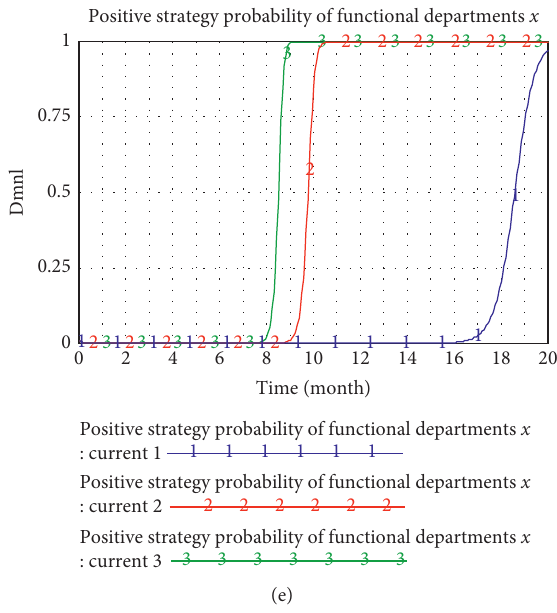
� 4, Current 2: C � 6, and 3 3